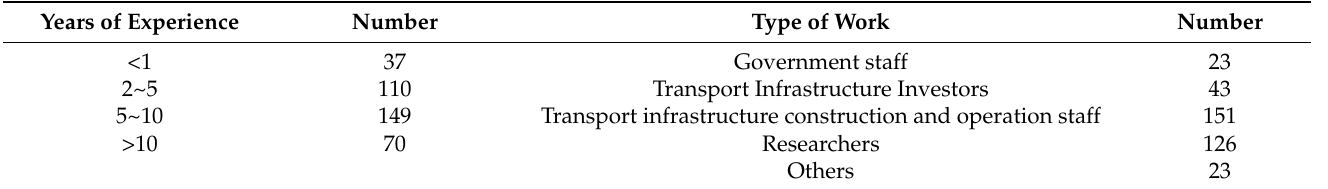
Table 2. Structure of the surveyed population.